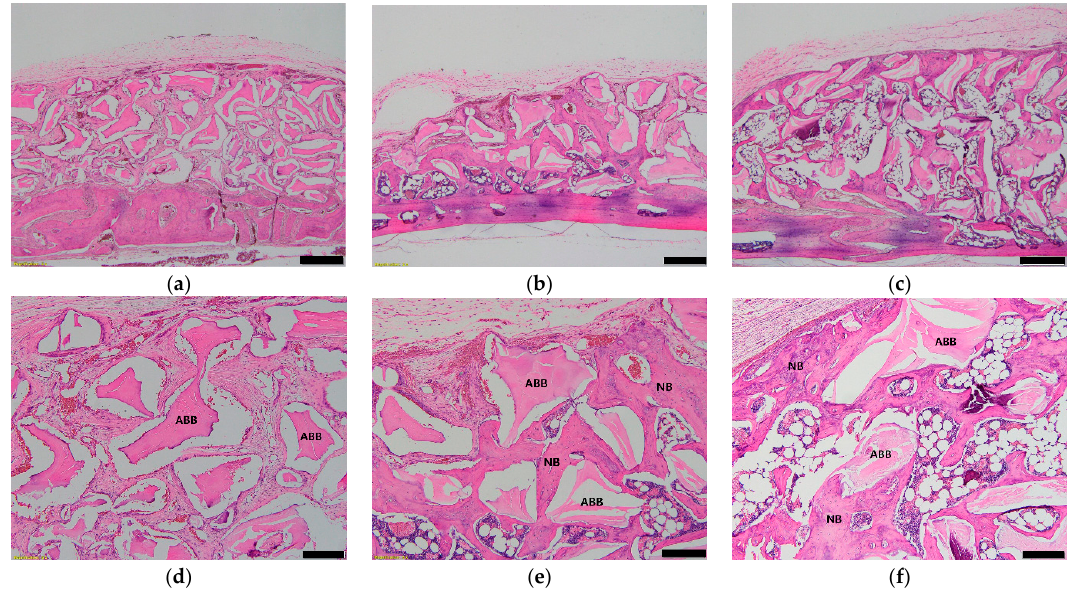
Figure 4. Histological images (hematoxylin and eosin staining) at 6 weeks after operation. ( a , d ) Control group, ( b , e ) ABB / low BMP, and ( c , f ) ABB / high BMP. ( d – f ) show high magnification of ( a – c ), respectively. ( a – c ): original magnification 40 × , bar = 500 µ m. ( d – f ): original magnification 100 × , bar = 200 µ m.